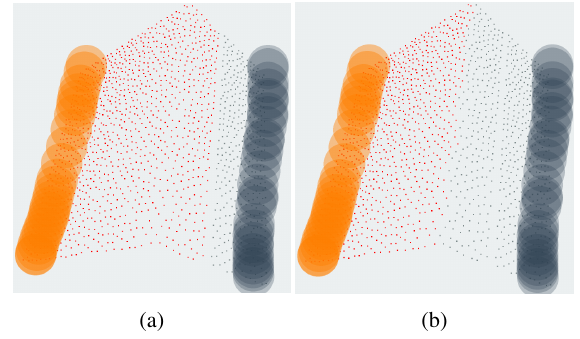
Figure 4: An example shows the difference of the two definitions of edge weights: (a) weights defined using Euclidean distance (see Equation 2); (b) weights based on normals (see Equation